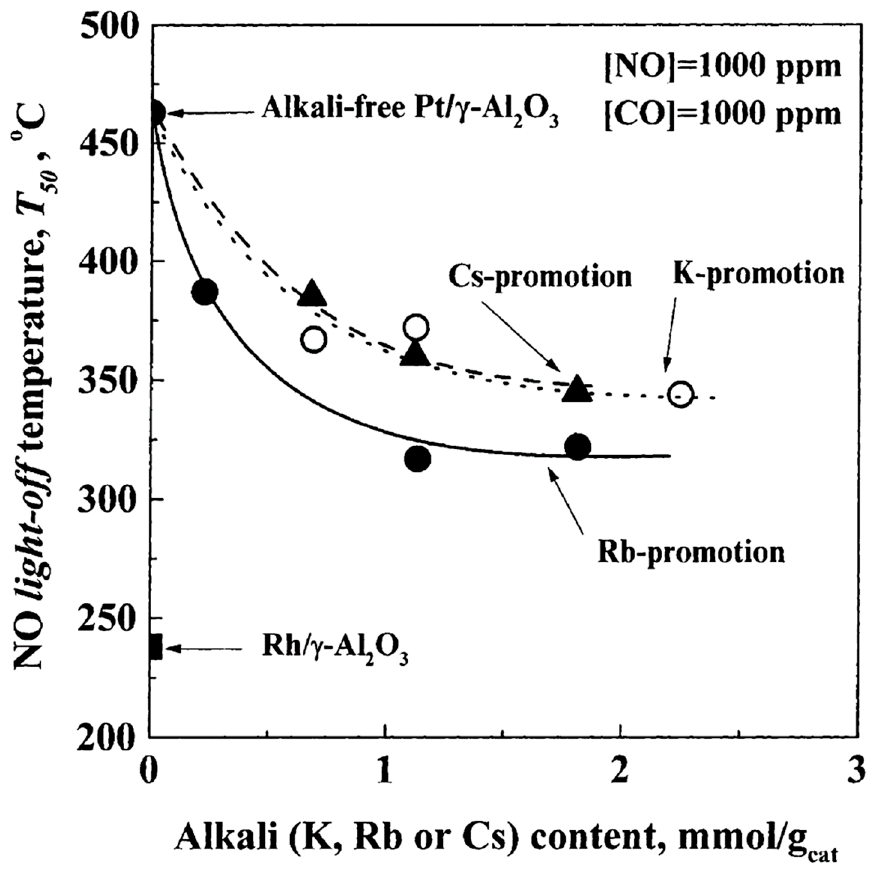
Figure 11. Effect of K-, Rb- or Cs-promotion on the NO light-off temperature (T 50 ) for Pt/NO + CO system. Conditions: [NO] = 1000 ppm, [CO] = 1000 ppm, total gas flow rate F t = 80 cm 3 STP/min; catalyst weight 8( ± 0.2) mg. (w/F t = 6 × 10 − 3 g s/cm 3 ). (Reprinted with permission from Ref. [53];